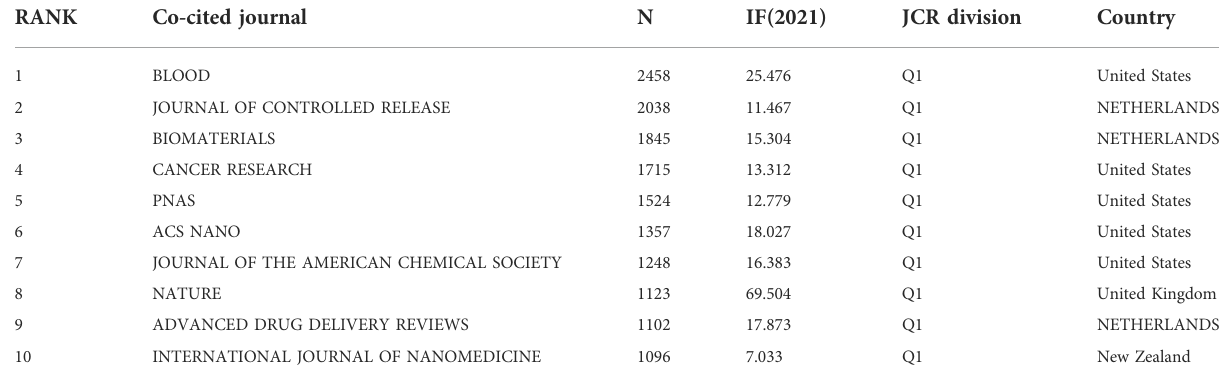
TABLE 2 The top 10 co-cited journals of Nanoparticles-leukemia-related research.